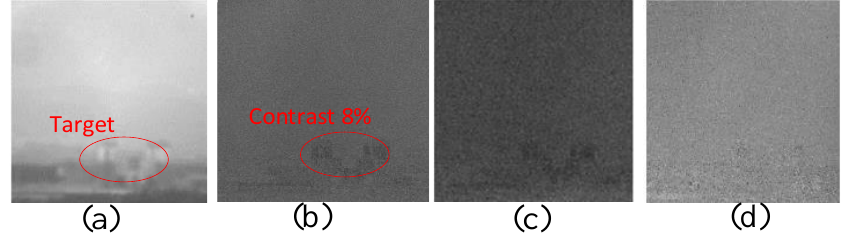
Figure 7. 530 nm band image ( a ) Intensity images ( b ) Polarization images ( c ) Line polarization im- ages ( d ) Polarization angle images.